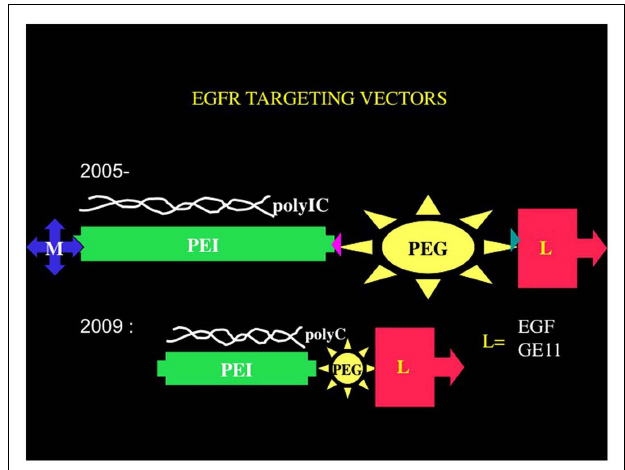
FIGURE 2 | Chemical vectors targeting the EGFR. The core structural elements of the chemical vectors targeting the EGFR consists of branched polyethyleneimine tethered by polyethyleneglycol to an EGFR homing ligand EGF or a peptide GE11.The tetraconjugate possesses a melittin moiety that facilitates endosomal release.The triconjugate is composed of a linear and shorter polyethyleneimine molecule tethered to the EGFR homing ligand via a short